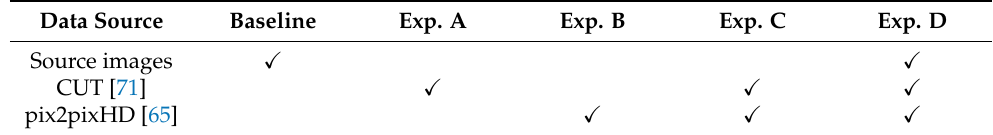
Table 2. Data combination for each experiment.